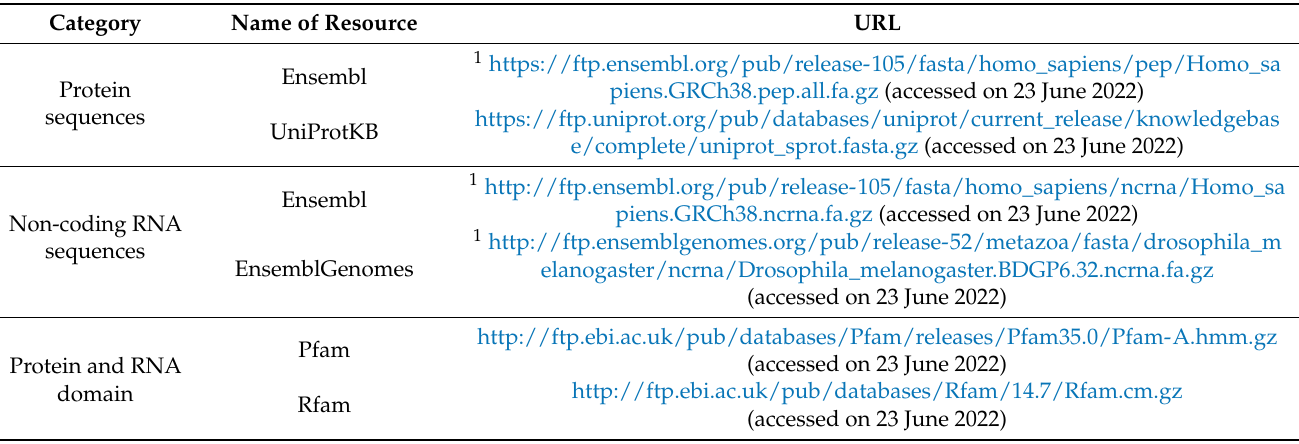
Table 1. Source of reference